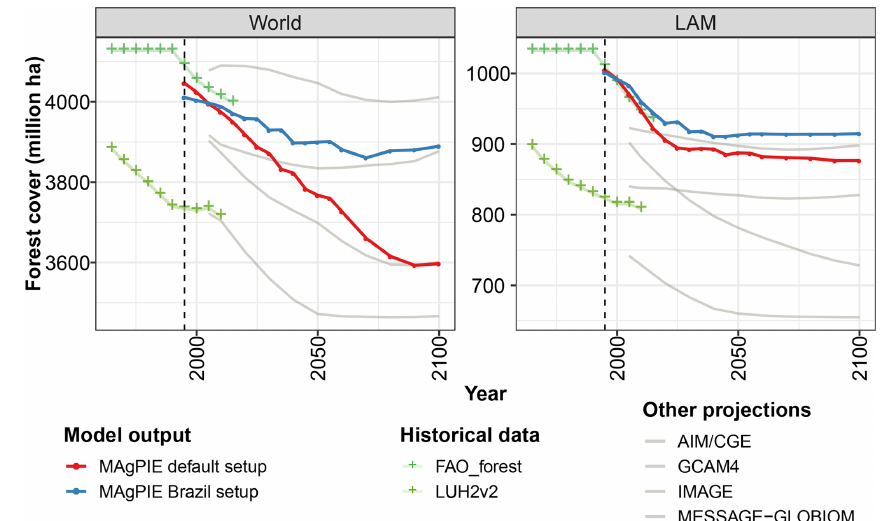
Figure 5. Comparison of global and Latin American forest cover with historical data sets and projections of other models.